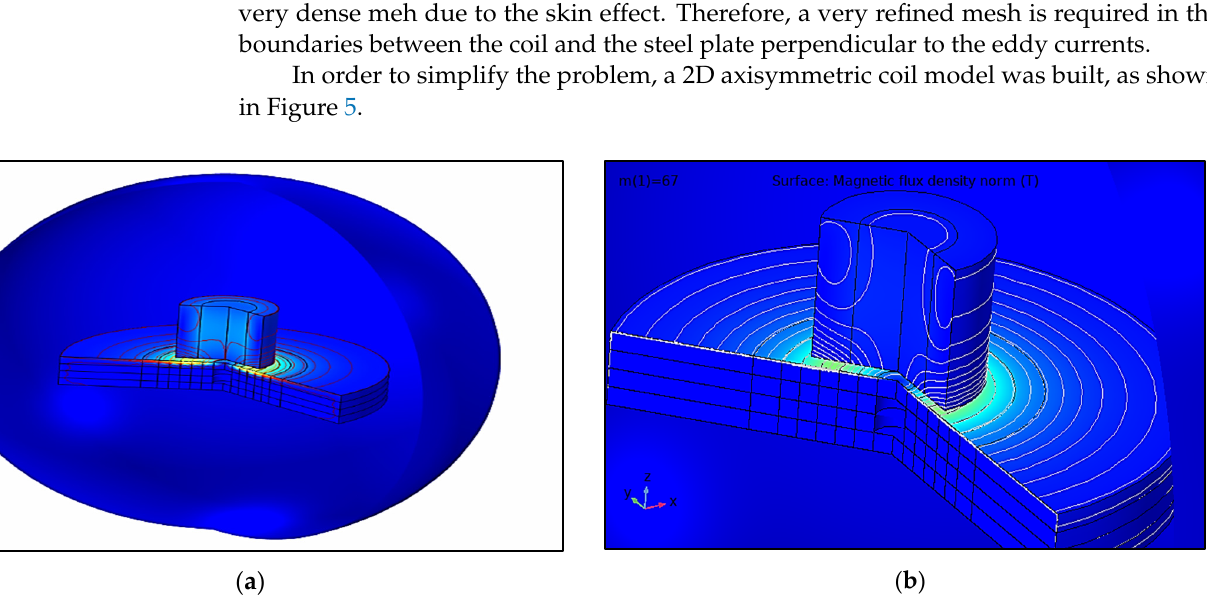
Table 4. The mesh parameters obtained from mesh convergence